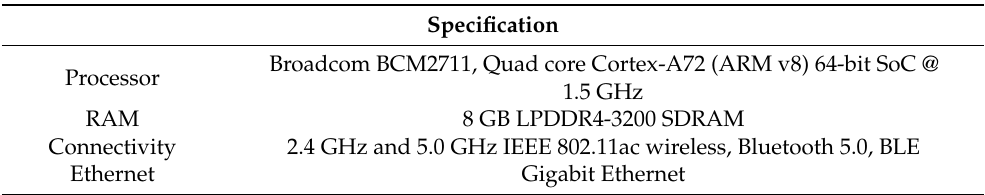
Table 3. Raspberry Pi 4 (8 GB) technical specifications [66].